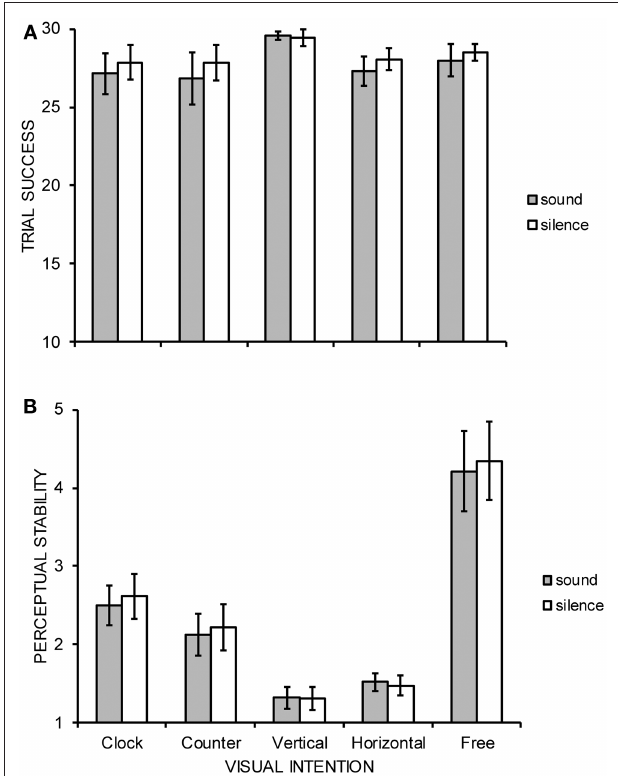
Figure 2 | group mean (A) trial success and (B) perceptual stability judged on a 7-point scale (1 = extremely stable, 7 = extremely unstable) of five possible interpretations of stroboscopic alternating motion under conditions of concurrent auditory stimulation or silence. Error bars denote